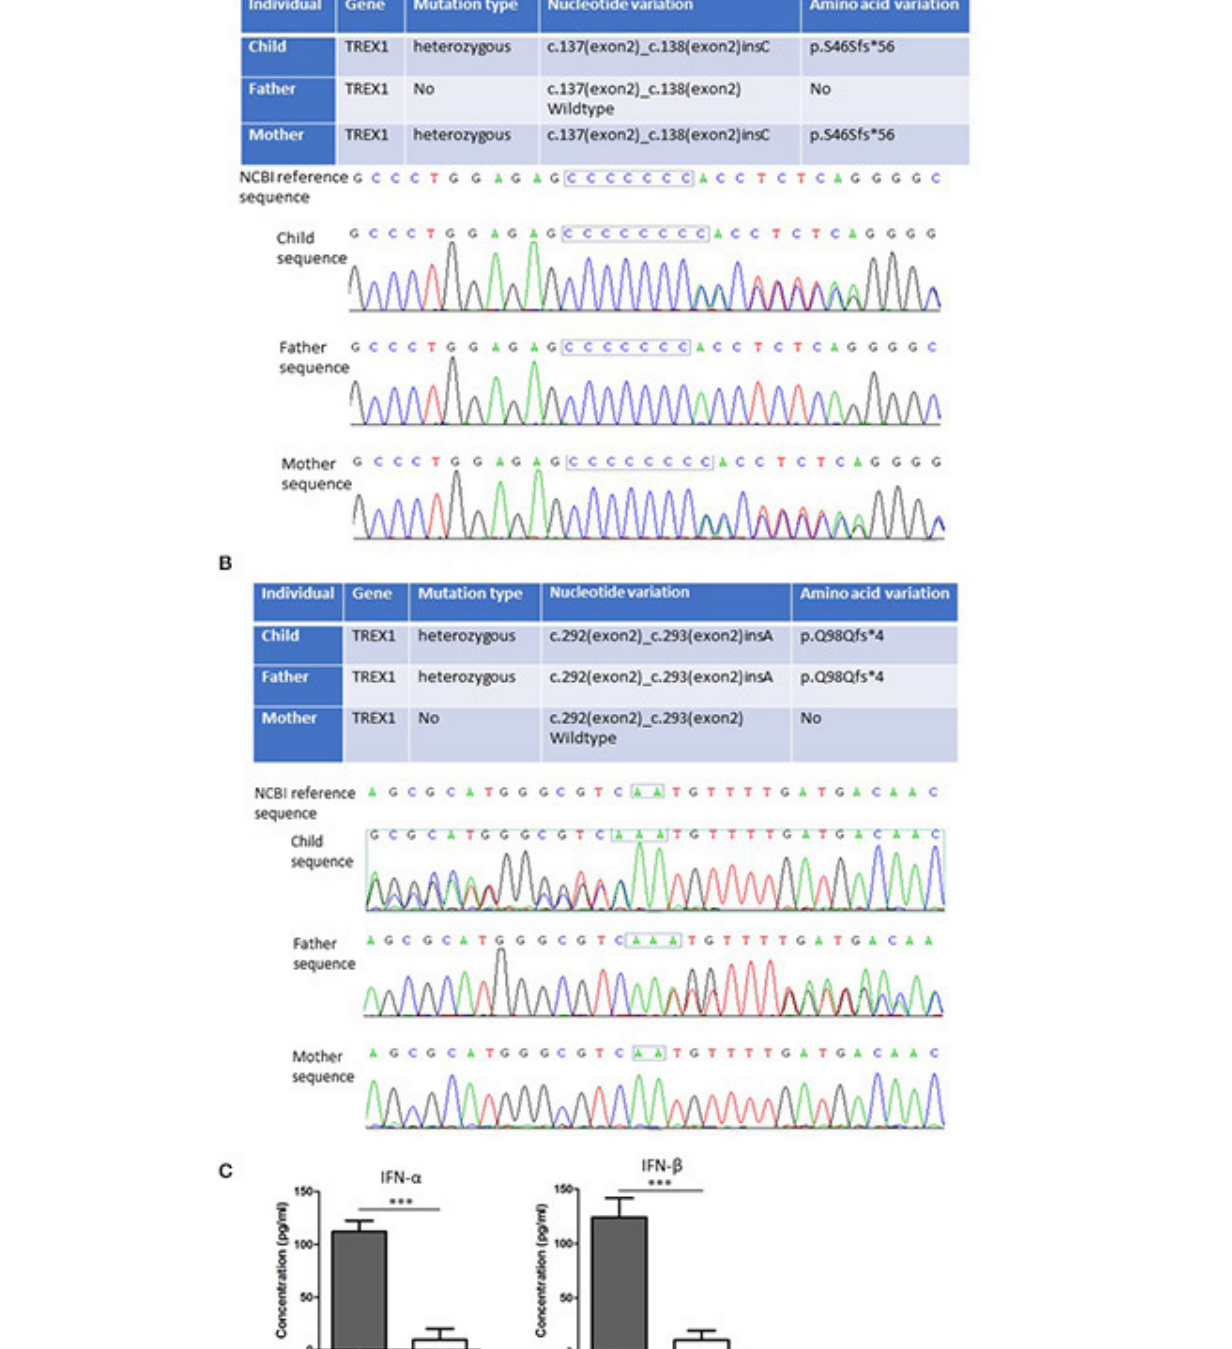
Frontiers in Pediatrics |